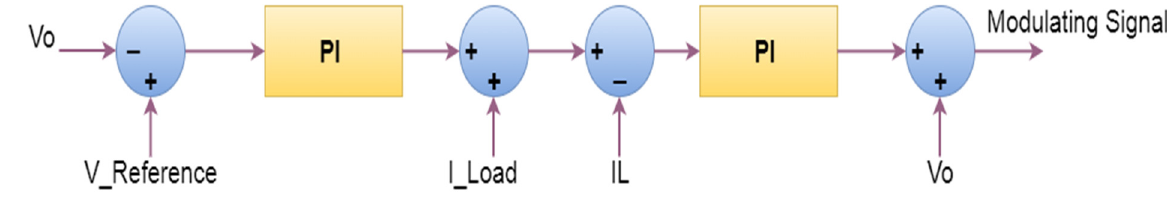
Figure 18. Output voltage control of an MLI by PI controller.